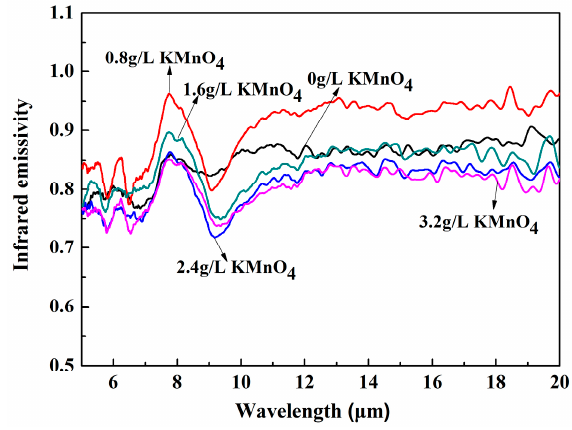
Figure 8. Infrared emissivity curves of the MAO ceramic coatings with different KMnO 4 concentrations within a waveband of 5–20 μ m.